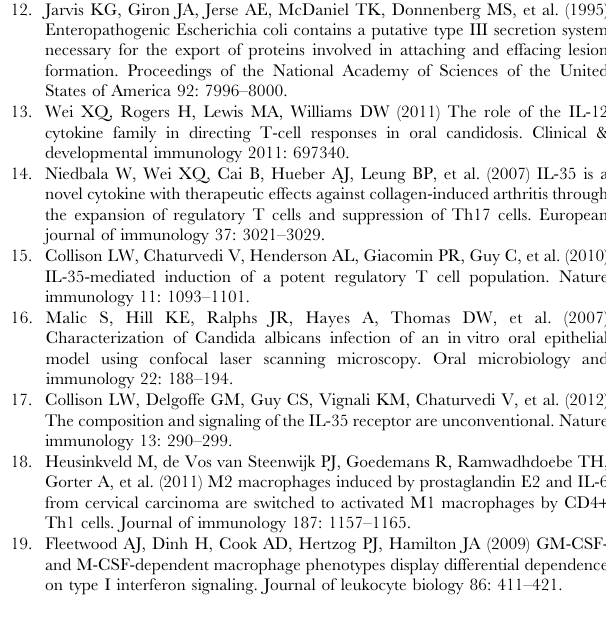
Figure S1 M2 macrophages expressed significant high- er TLR4 levels than M1 macrophages, ** P , 0.01. (PPTX) Figure S2 IL-35 and IL-27 did not suppress LPS induced IL-12p70 production by M2 macrophages. (PPTX) Figure S3. A. EBI3 mRNA knockdown in RAW264.7 cells. B. EBI3 mRNA knockdown rescued HKC induced suppression for LPS stimulated IL-12p70 production. (PPTX) Figure S4 Heat killed Candida albicans (HKC) alone did not induce IL-27 production in M2 macrophage, and increasing the dose of HKC did not suppress LPS induced IL-27 production.